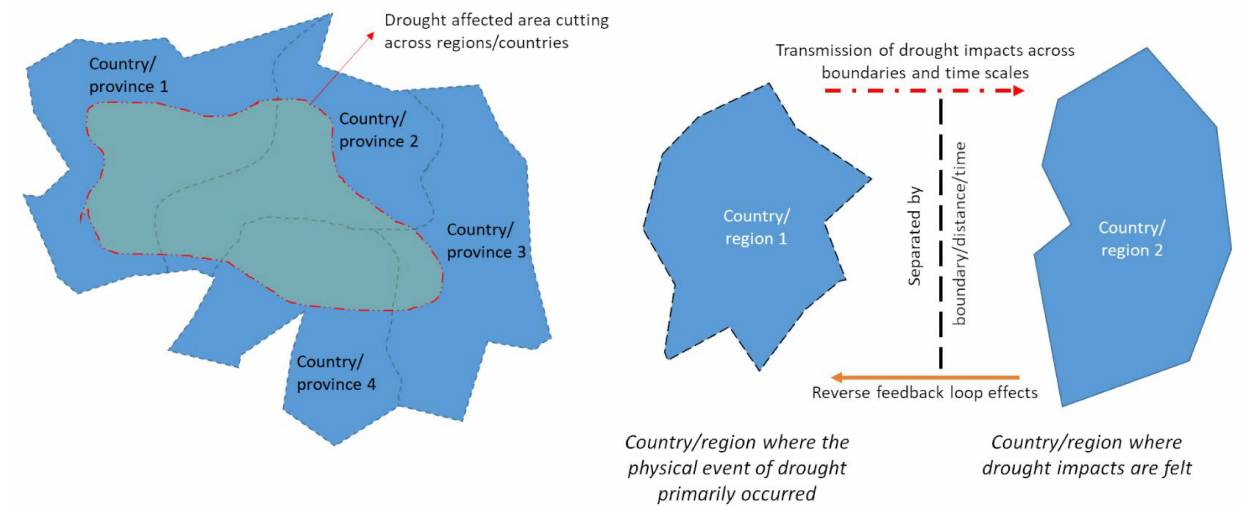
Figure 1. The distinction between a regional drought ( image on the left ) and transboundary drought risk ( image on the right ). The figure on the right depicts how drought risks are trans- mitted across